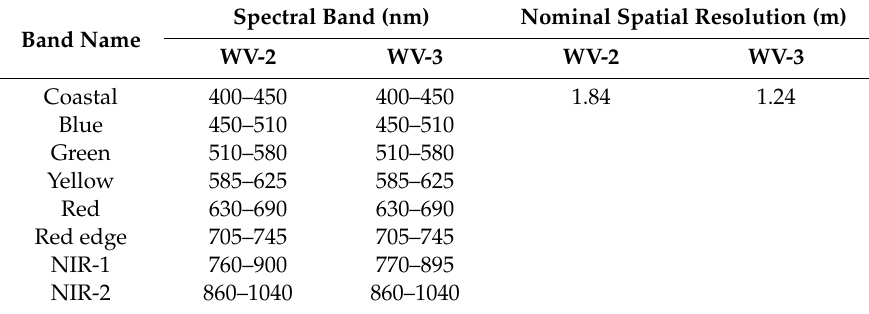
Table 2. 8 Visible-NIR multispectral bands of WV-2 coincident with WV-3 [41].